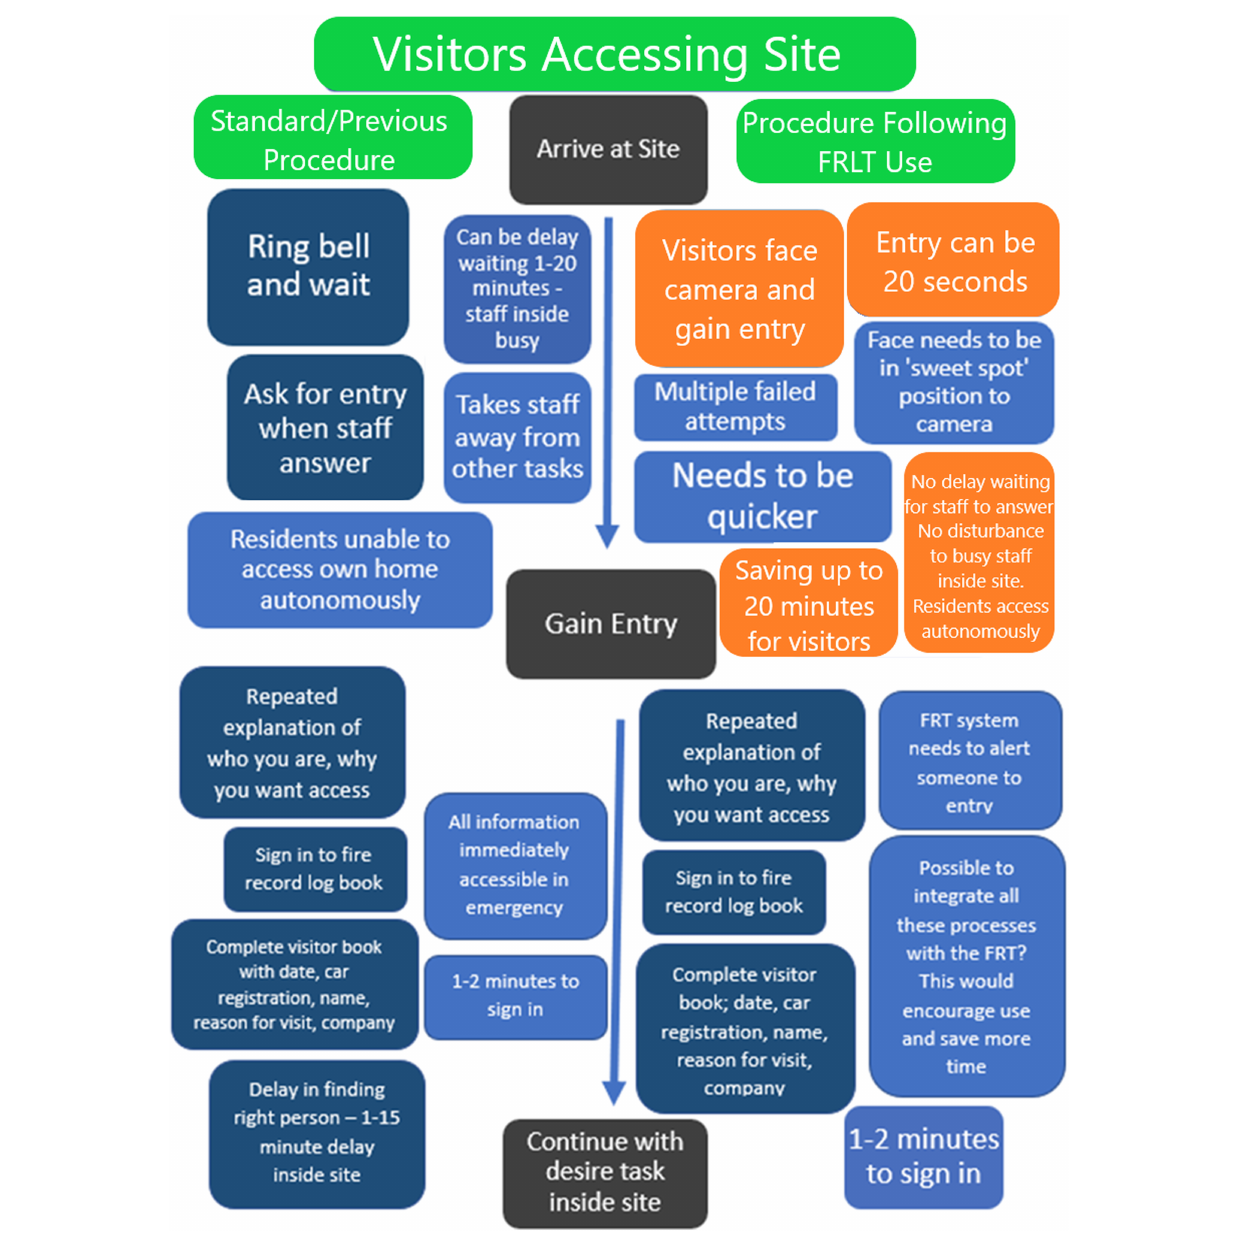
FIGURE 4 Process map for accessing residential care sites before FRLT implementation (previous procedure – left of fi gure) and following FRLT implementation (right of fi gure) for